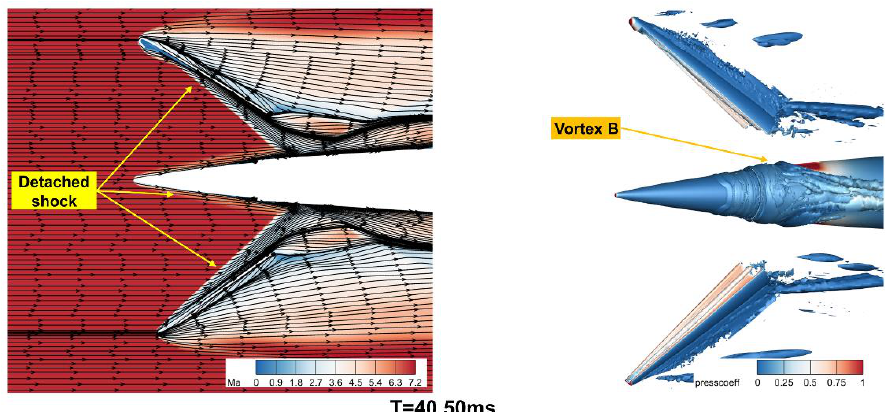
Figure 31. The contour of the streamline and Mach number ( left ), and iso-surface of Q-criterion ( right ) at Time = 40.50 ms.